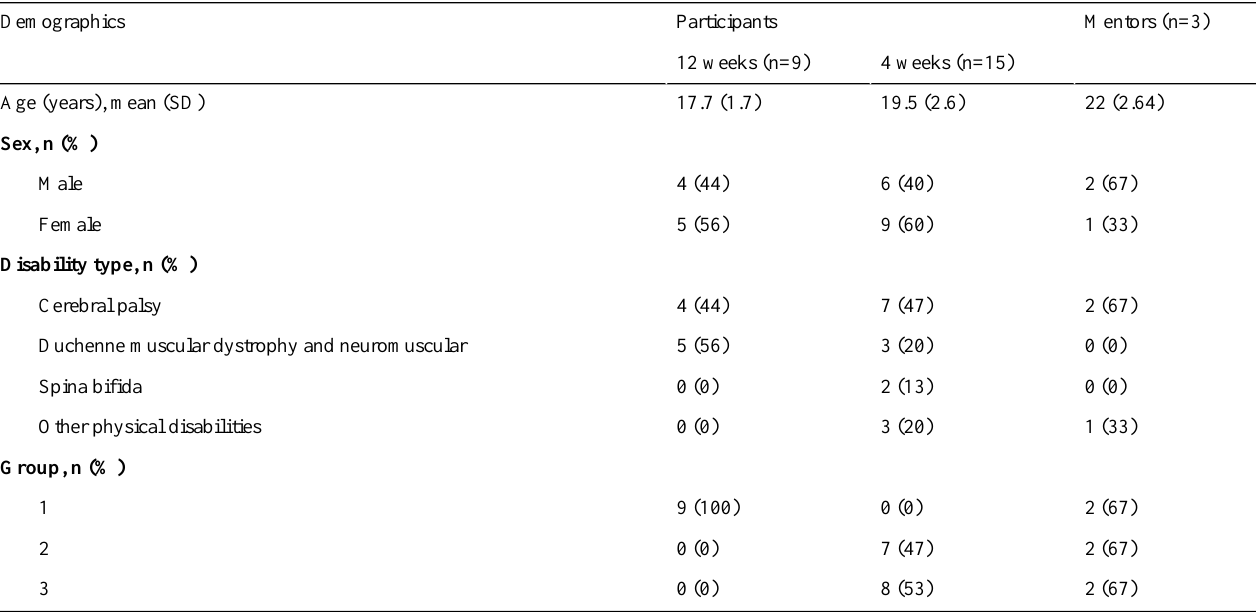
Table 1. Mentee and mentor demographics.